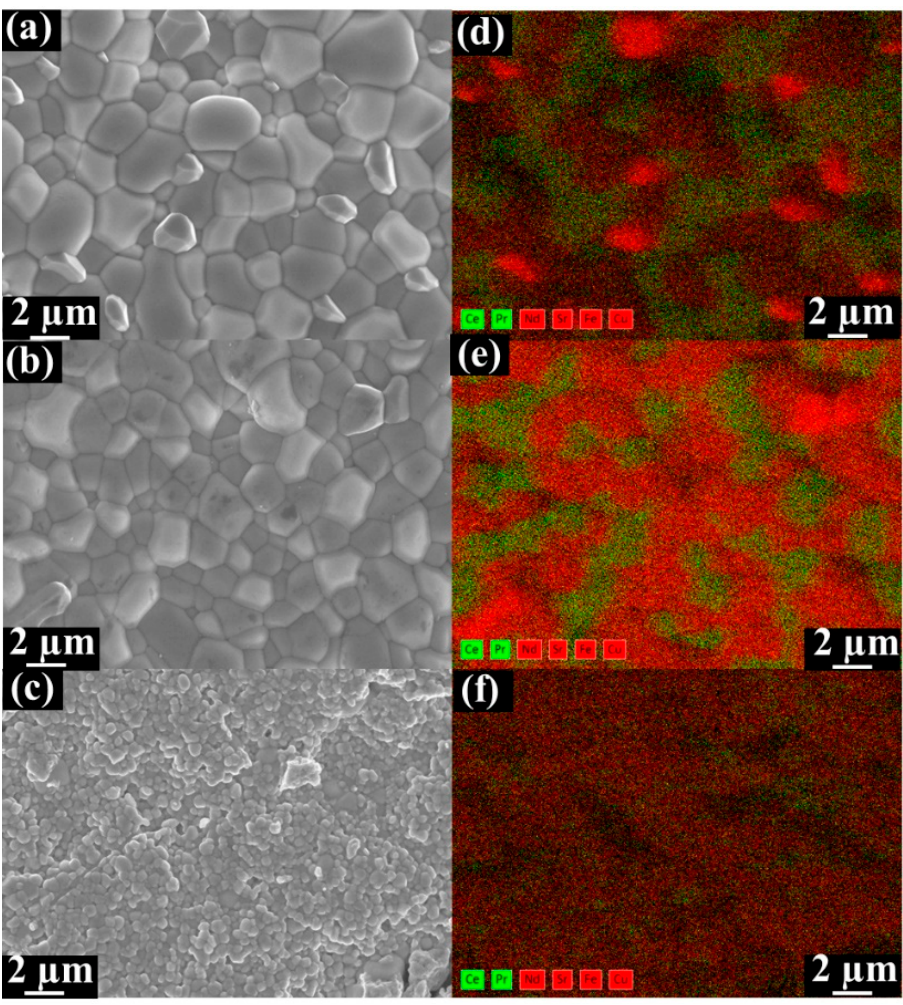
Figure 2. SEM and the corresponding energy-dispersive X-ray spectroscopy (EDXS) images of fresh unpolished Ce 0.9 Pr 0.1 O 2 − δ –Nd x Sr 1 − x Fe 0.9 Cu 0.1 O 3 − δ dual-phase membranes. ( a ) Ce 0.9 Pr 0.1 O 2 − δ –Nd 0.2 Sr 0.8 Fe 0.9 Cu 0.1 O 3 − δ ; ( b ) Ce 0.9 Pr 0.1 O 2 − δ –Nd 0.5 Sr 0.5 Fe 0.9 Cu 0.1 O 3 − δ ; ( c ) Ce 0.9 Pr 0.1 O 2 − δ –Nd 0.8 Sr 0.2 Fe 0.9 Cu 0.1 O 3 − δ . Contribution to the EDXS mapping data ( d – f ) resulting from the fluorite phases (Ce L α and Pr L α ) are